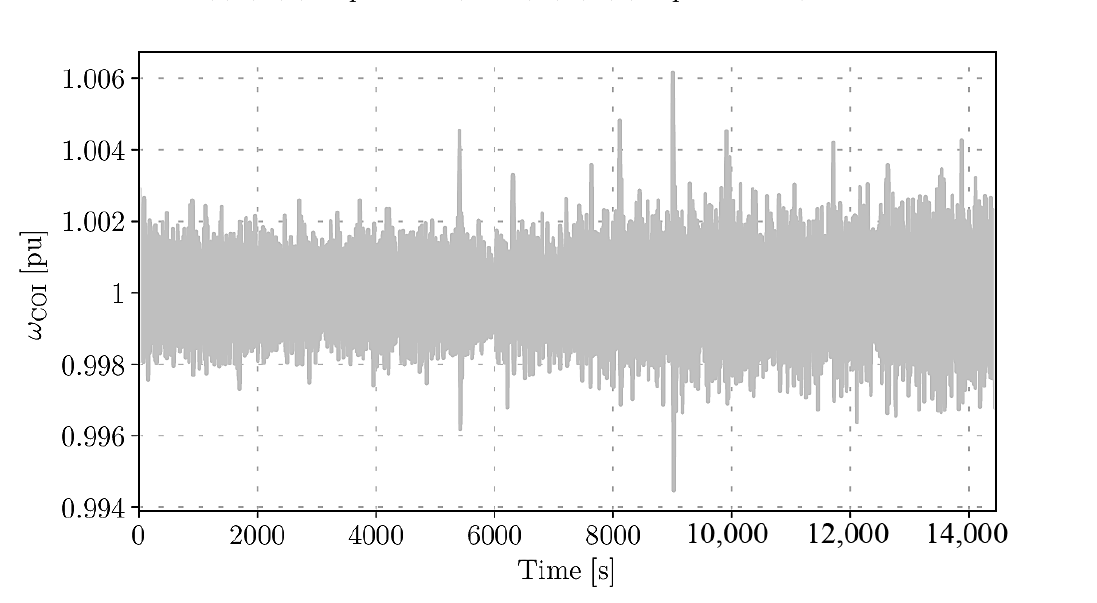
Figure 7. Trajectories of ω COI for 15-min time period and complete SUC.